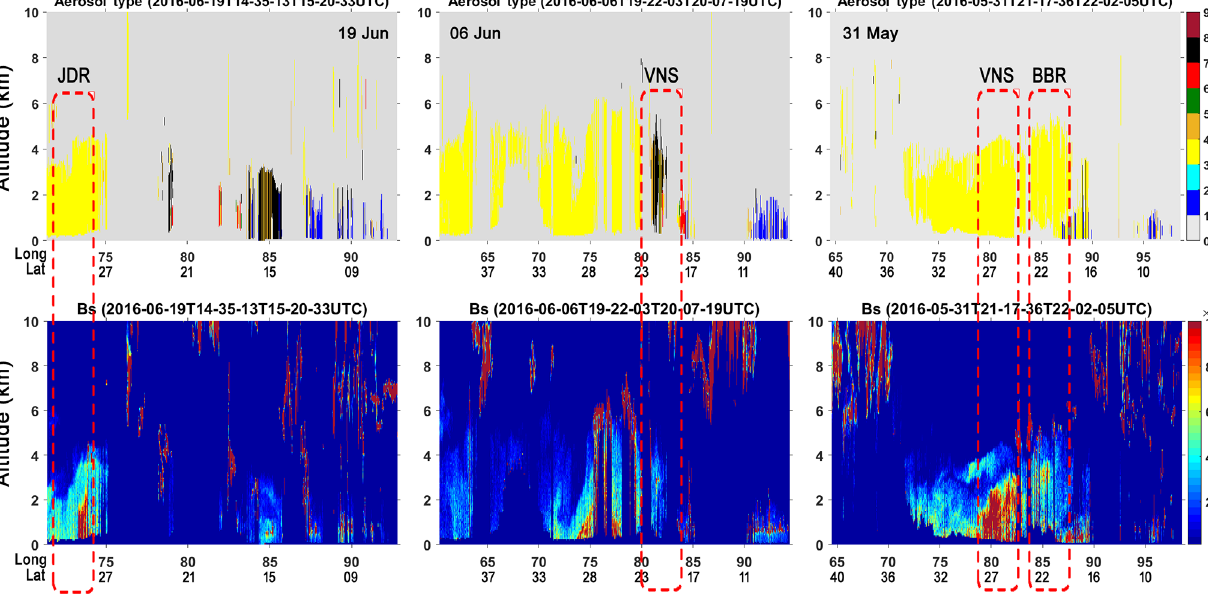
Figure 10. Transects of (a) aerosol types (1 – marine, 2 – marine mixture, 3 – dust, 4 – dust mixture, 5 – clean/background, 6 – polluted continental, 7 – smoke, 8 – volcanic) and (b) backscatter coefficients (Bs, km − 1 Sr − 1 ) at 1064nm obtained during the period of aircraft observation corresponding to the overpass of the